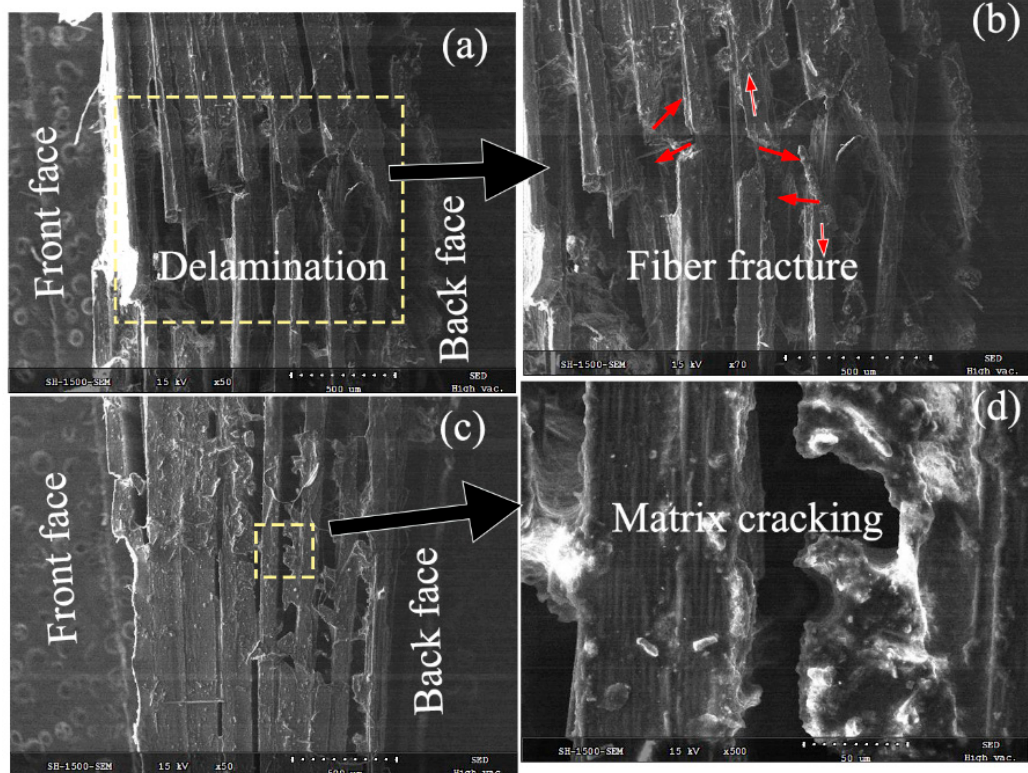
Figure 16. Fracture patterns of the saturated specimen subjected to the impact velocity of 45 m/s using the SEM technique. ( a ) Delamination damage; ( b ) Fiber facture; ( c ) Matrix/fiber interface; ( d ) Matrix cracking.